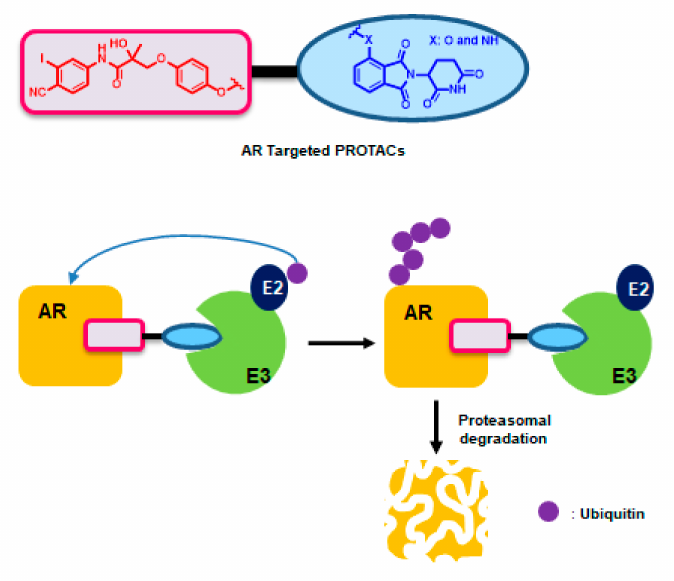
Figure 2. Strategy for androgen receptor (AR) degradation using PROTACs consisting of a bicalu- tamide analog and